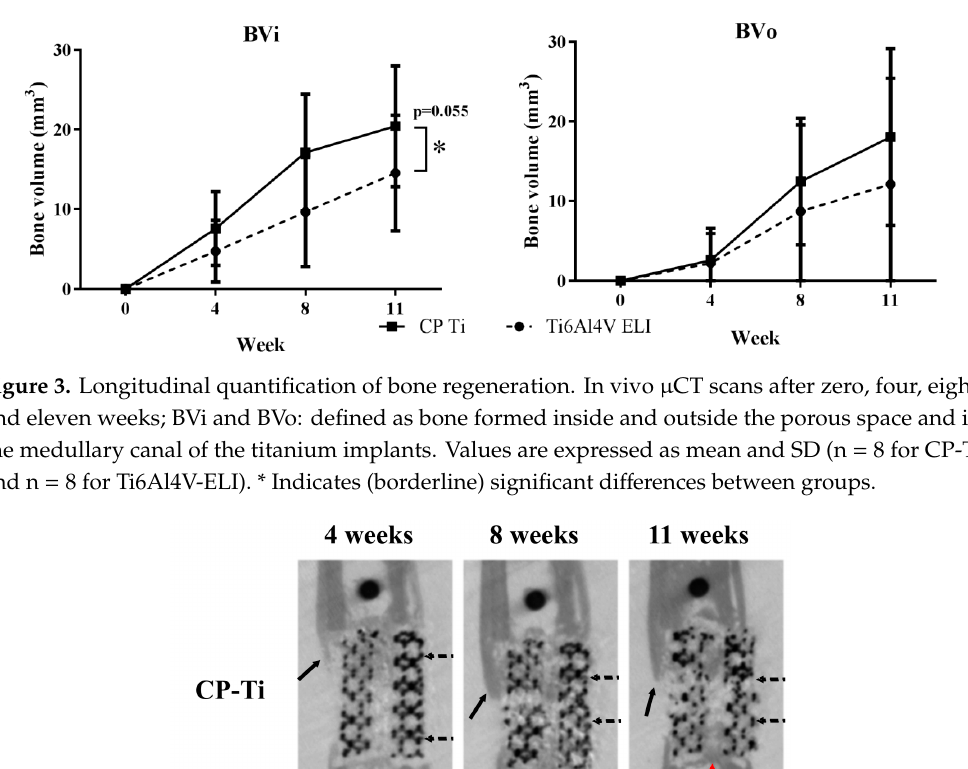
Figure 5. Histological evaluation of bone bridging. Representative transversal sections of femur defects eleven weeks after implantation of porous titanium implants; CP-Ti ( A ) and Ti6Al4V-ELI ( C ),